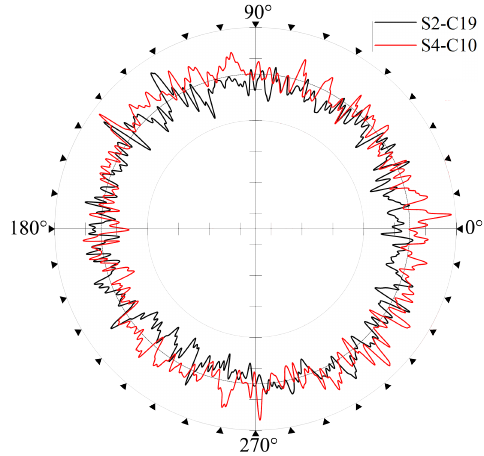
Figure 13. Composite drawing of roundness error for section 19 of shaft 2 and section 10 of shaft